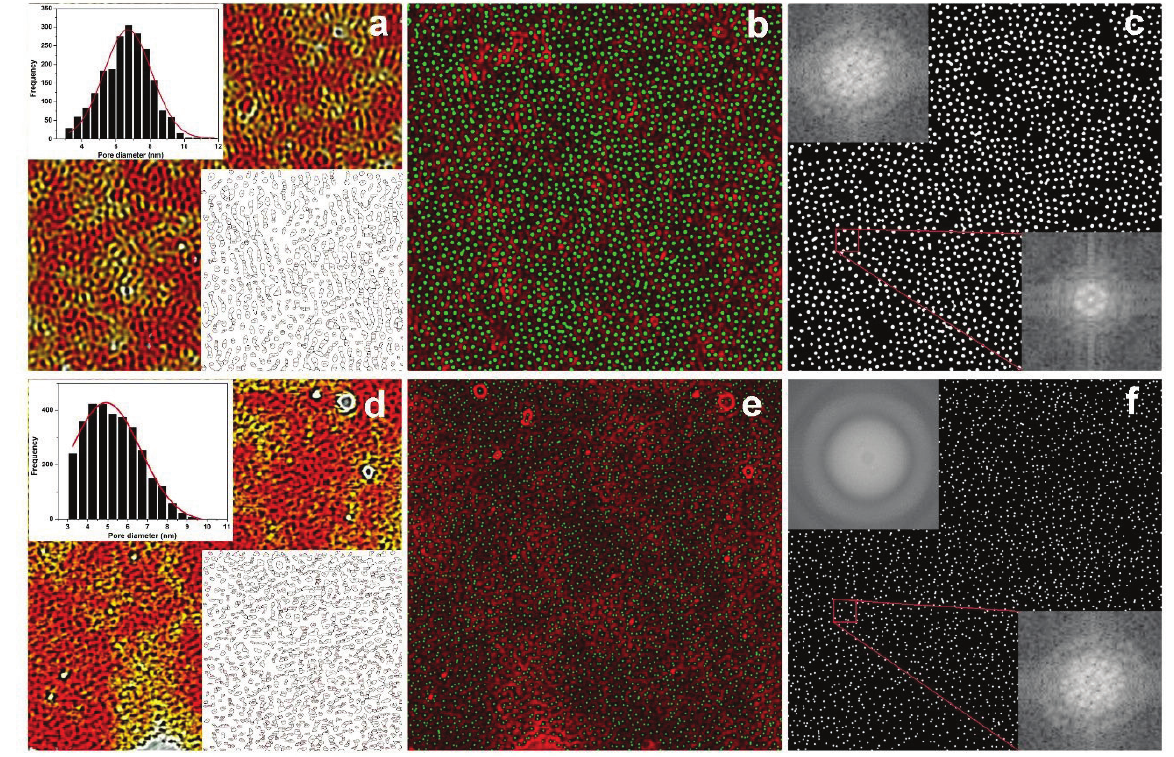
Figure 6: Threshold of AFM height image after acid vapor treatment for Polymer 1 (a) and Polymer 2 (d) inset represents the calculation of pore size and pore size distribution. Composite image of the threshold image (red channel) and reconstructed pores (green channel) for Polymer 1 (b) and Polymer 2 (e), respectively. Reconstructed pores for Polymer 1 (c) and Polymer 2 (f), respectively, inset shows the local (30 × 30 nm) and global (500 × 500 nm)